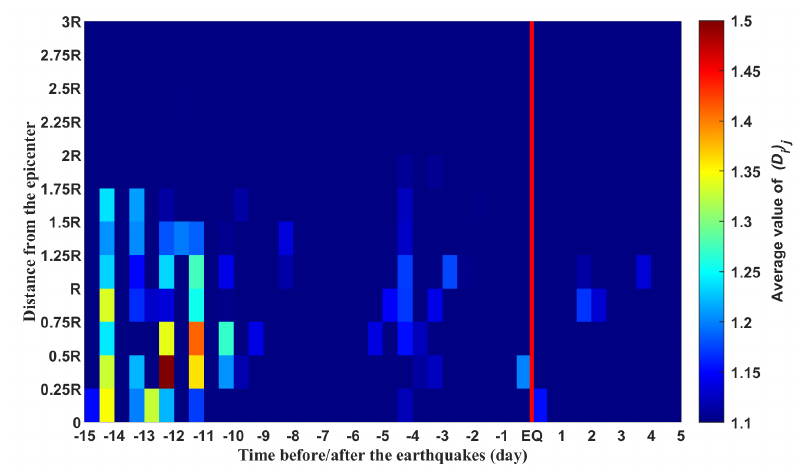
Figure 4. Grid showing the result of the superposed epoch method as a function of normalized Dobrovolsky’s radius and as a function of the difference between the time of the data registration along the orbits and the occurrence time of the earthquakes. The vertical red line corresponds to the occurrence time of the 10,093 earthquakes with M ≥ 4.8 considered in this study. The dimension of a cell is 0.25R × 12 h. The value inside each cell corresponds to the average value of ( D i ) j and is coded according to the color scale on the right.